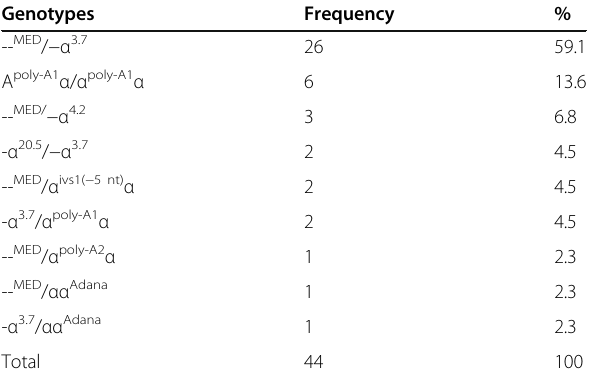
Table 3 HbH disease genotypes